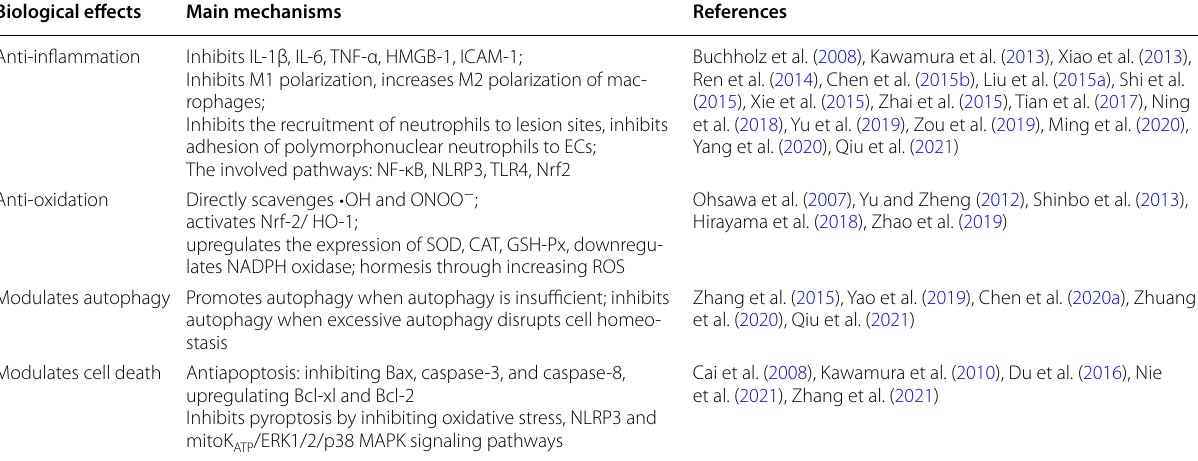
Table 1 The proposed biological effects of molecular